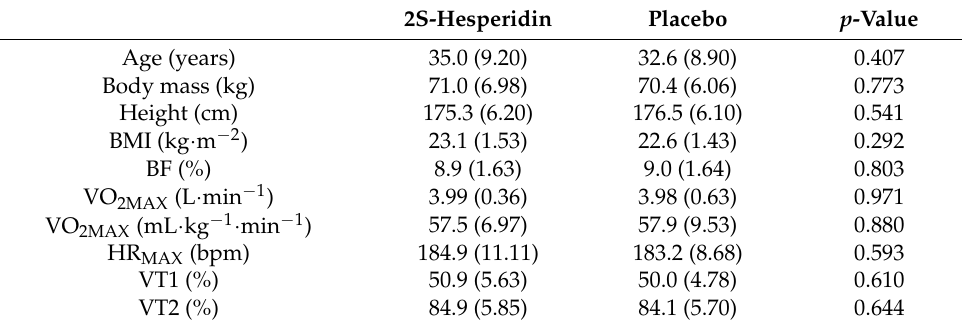
Table 1. Baseline general characteristics and training variables of the